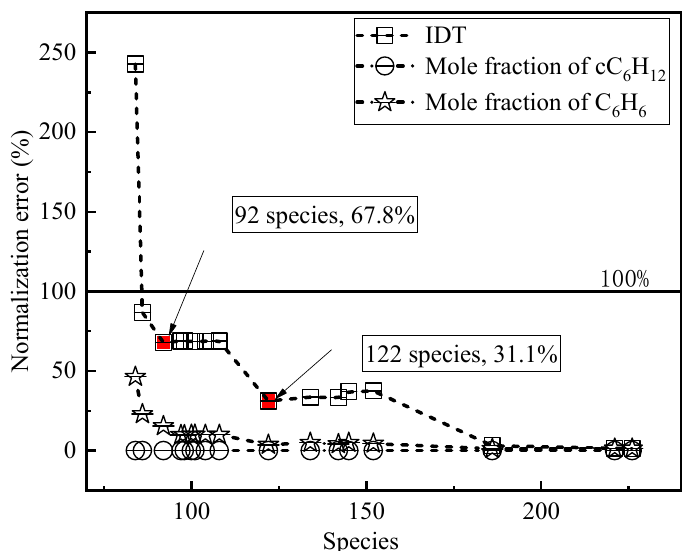
Figure 1. Skeletal mechanism species obtained by direct relationship graph error propagating (DRGEP) and normalized error of the corresponding prediction.